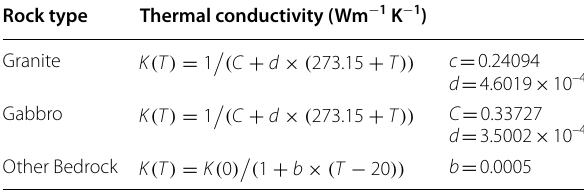
Based on Miao et al. (2014) for granite and gabbro. Based on Funnell et al. (1996), K (0) indicates thermal conductivity at room temperature for other rocks